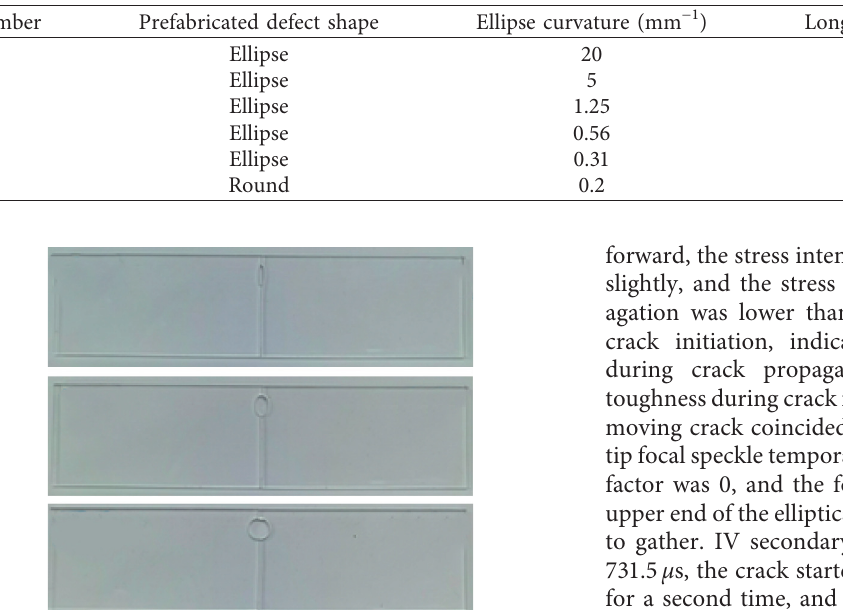
Table 1: Specimen dimensions.